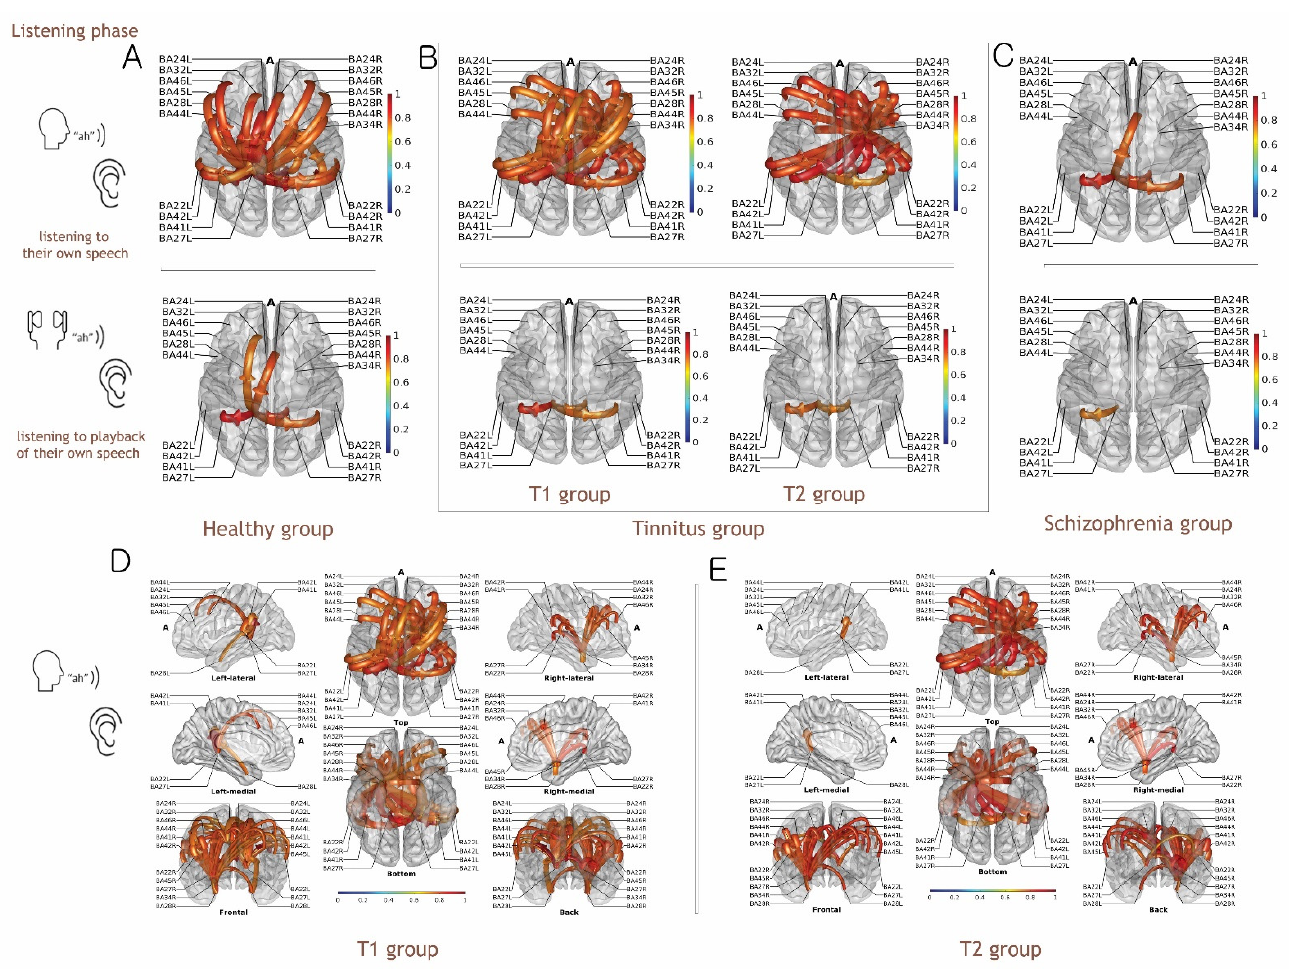
Figure 3. Granger causal connectivity of grand-averaged evoked alpha activity during auditory stimulus time window (0 to 200 ms) in the Talk and Listen paradigm. ( A ) Healthy group. ( B ) Tinnitus groups: T1 (tinnitus without subjective hearing loss), T2 (tinnitus with subjective hearing loss). ( C ) Schizophrenia group. ( D ) Spatial representation of connectivity in the T1 group. ( E ) Spatial representation of connectivity in the T2 group. During the Talk paradigm, a dominance shift from hippocampal regions (BA34R) to left parahippocampal regions (BA27L) was observed in the healthy and T1 groups, compared with preparatory phase. However, the dominance shift was not observed in the T2 group. A few connectivities were present in the schizophrenia group. Color-scaled directional arrows link two causally connected regions of interest (ROIs) across 21 ROIs (BA24L/R, BA22L/R, BA27L/R, BA28L/R, BA32L/R, BA34R, BA41L/R, BA42L/R, BA44 L/R, BA45L/R, and BA46L/R). (A: anterior).